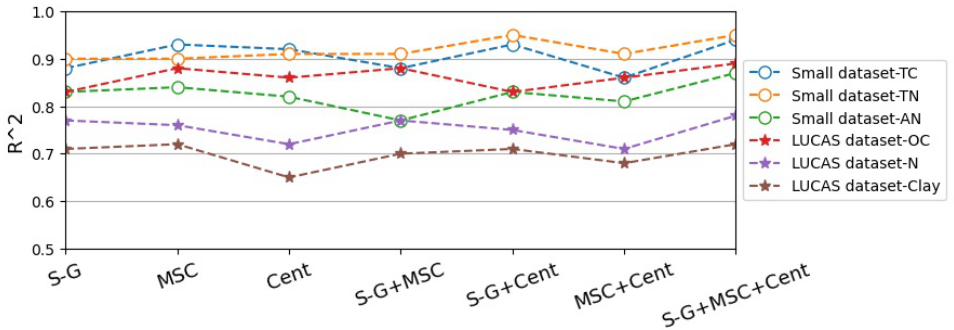
Figure 7. Comparison diagram of preprocessing effect on test set. (S-G refers to Savitzky-Golay smoothing algorithm, MSC refers to Multivariate Correction, Cent refers to Centralization methods.)